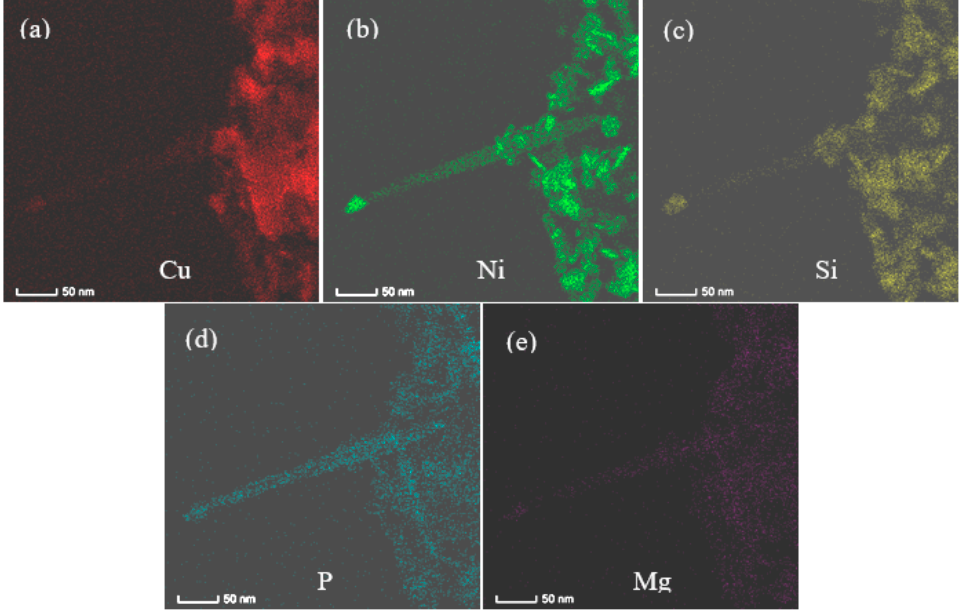
Figure 9. EDS element mapping images of plate-like precipitates of Figure 8 in C0 alloy aged at 500 °C for 16 h. ( a ) Cu, ( b ) Ni, ( c ) Si, ( d ) P, ( e ) Mg.